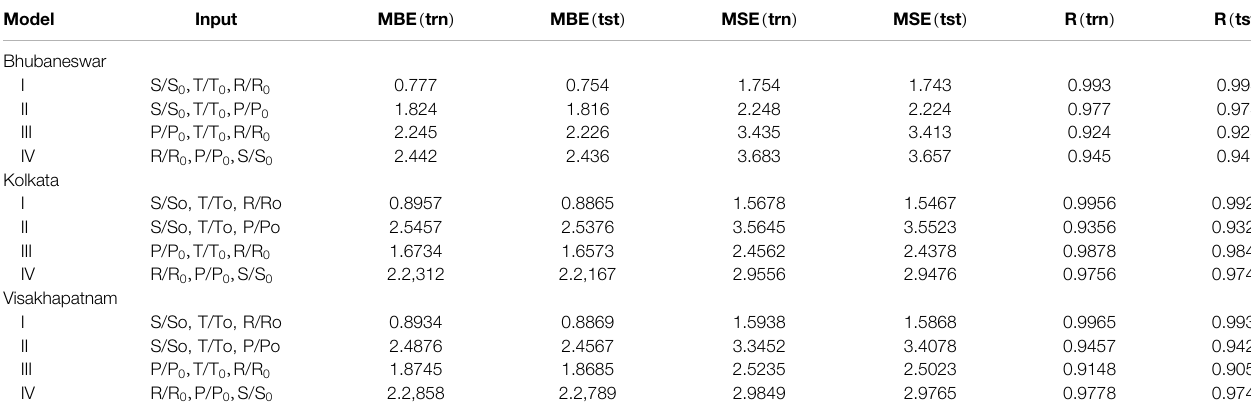
TABLE 7 | ANFIS models for Bhubaneswar, Kolkata, and Visakhapatnam (three inputs). Model